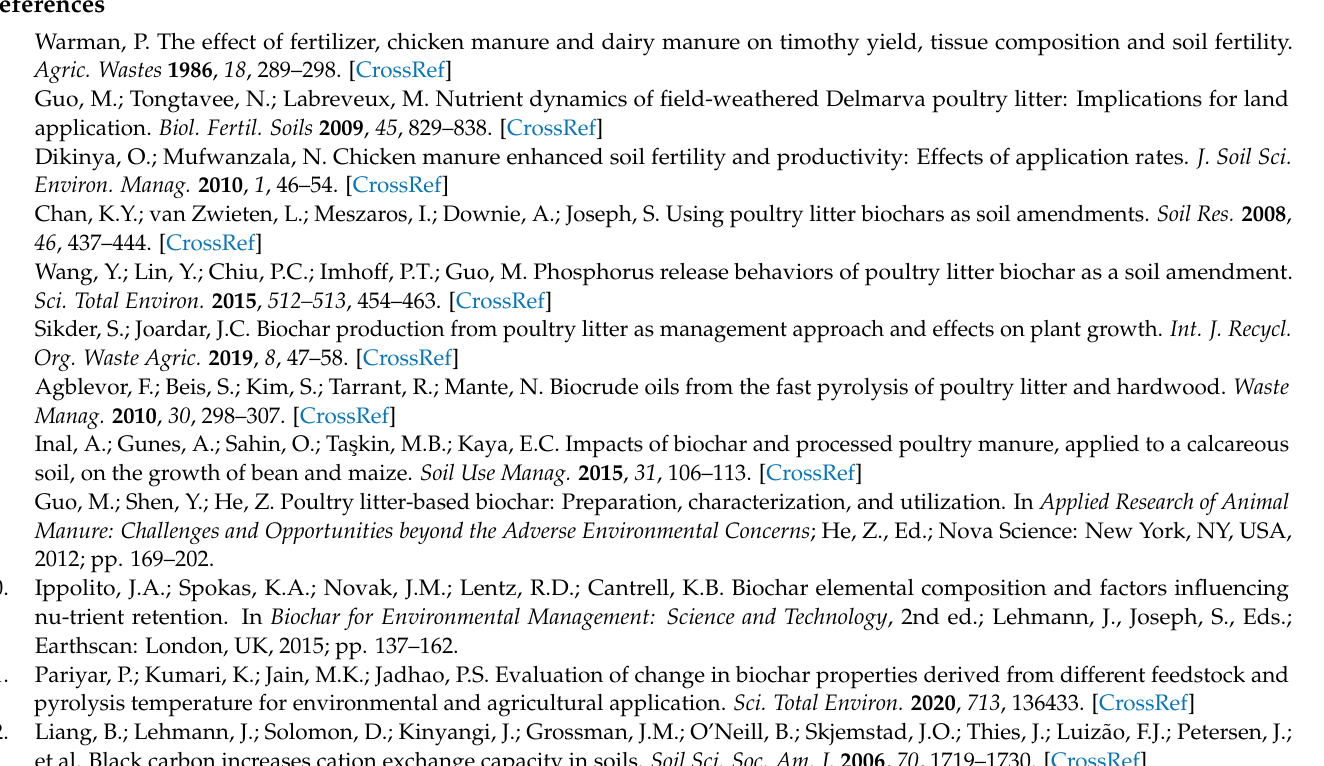
Table S2: Significant difference of CO 2 –C release of nine times monitoring between addition rates and treats compared to the control during 56 days of incubation; Table S3: Significant test of cumulative CO 2 –C, and water extraction solution pH and electrical conductivity after 56 days